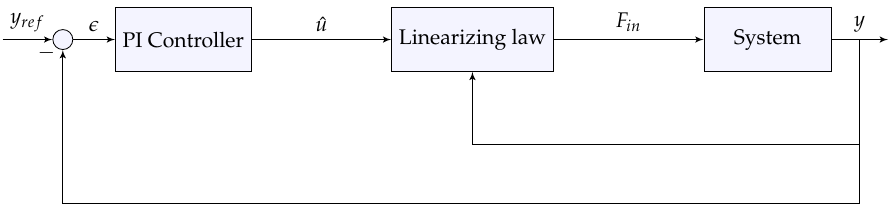
Figure 1. Generic Model Control (GMC)